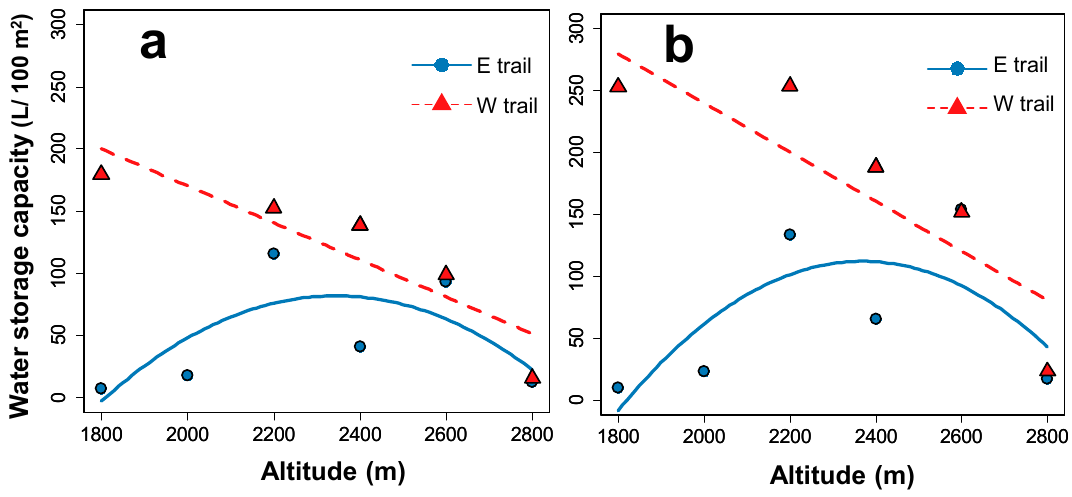
Figure 4. Change to water storage capacity of bryophyte communities within each plot along an altitudinal gradient. ( a ) Fresh samples, ( b ) Dry samples.